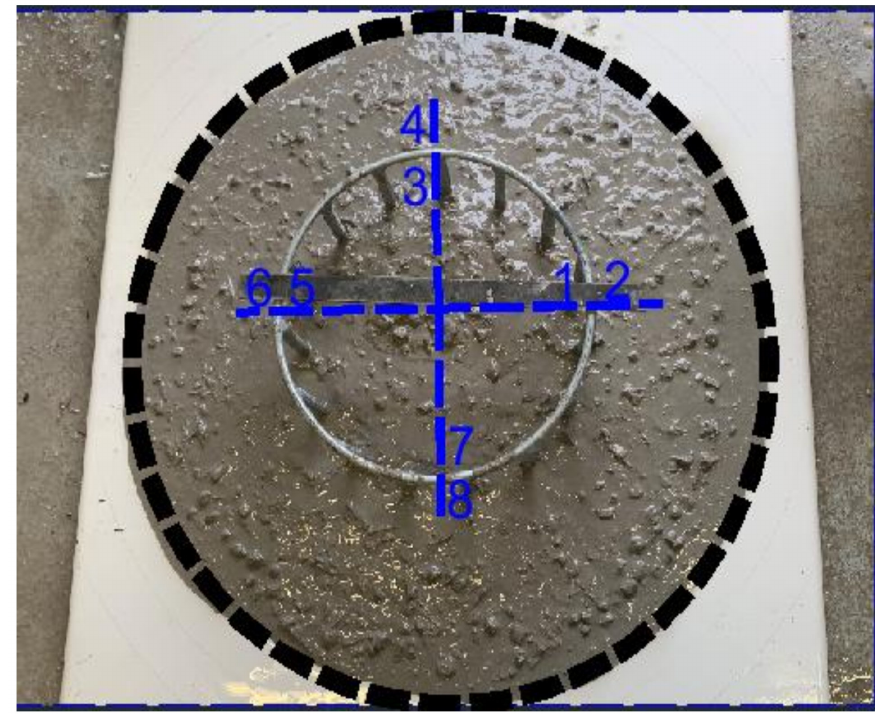
Figure 9. Locations of SCGC measured heights.